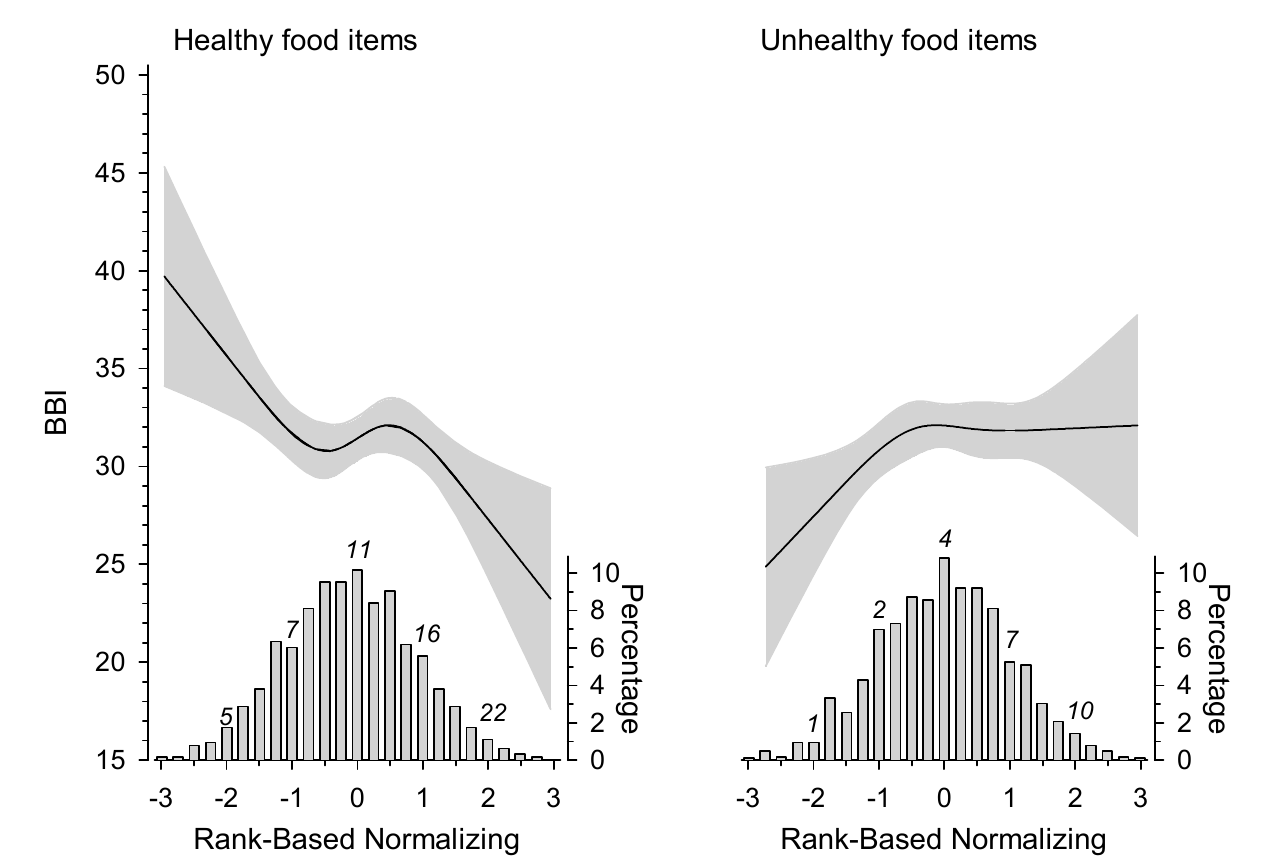
Figure 1. Relationship of the Bergen Burnout Indicator (BBI) score and the distribution of healthy and unhealthy food items consumed per day. The curves were derived from a 4-knot restricted cubic splines regression models. The models were adjusted for age, education years, leisure-time physical activity, smoking, and Body Mass Index. Gray areas represent 95% confidence intervals.